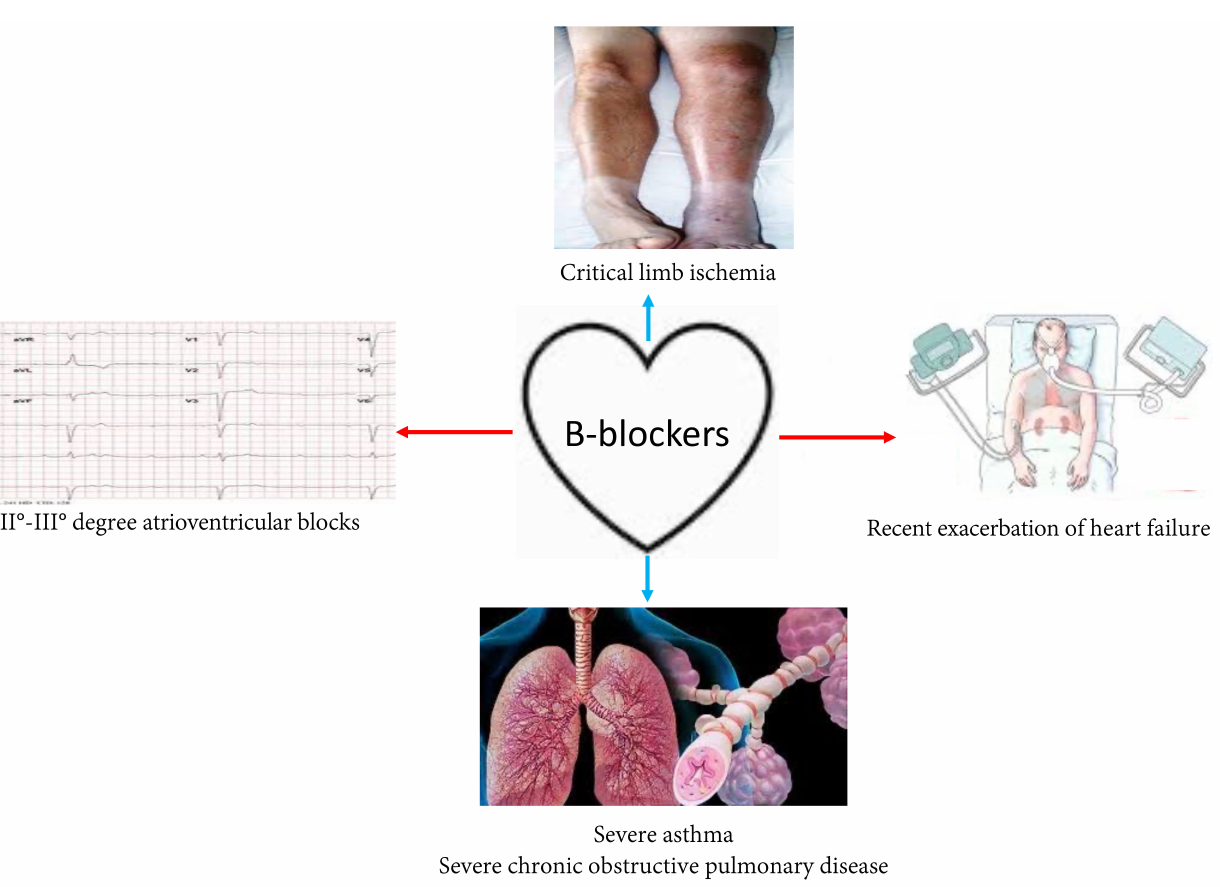
Figure 1. Cardiological (red arrow) and non-cardiological (blue arrow) contraindication to β -blockers